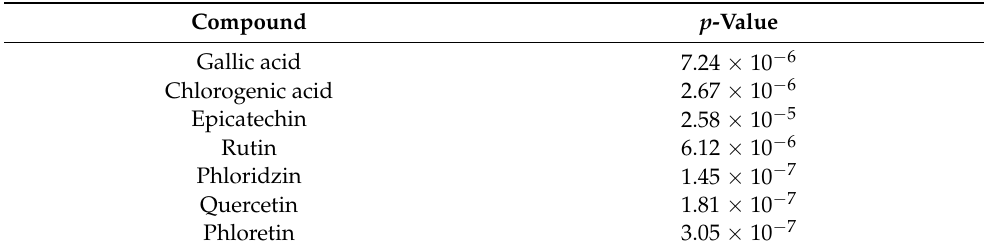
Table 4. Statistics for comparison of sensitivity of diode-array detector and charged aerosol detector based on calibration